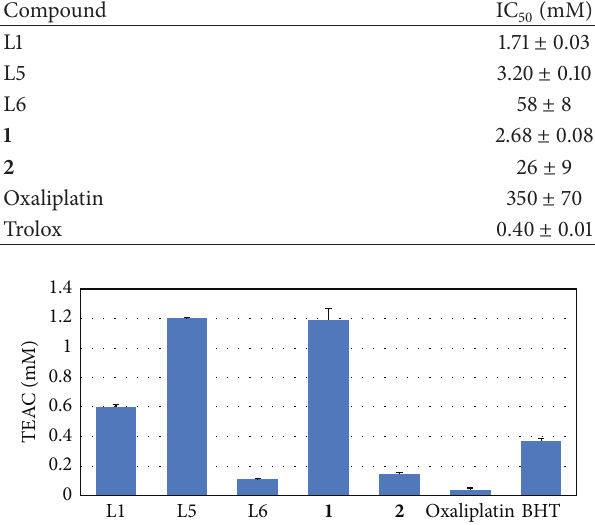
) in DPPH assay. 50